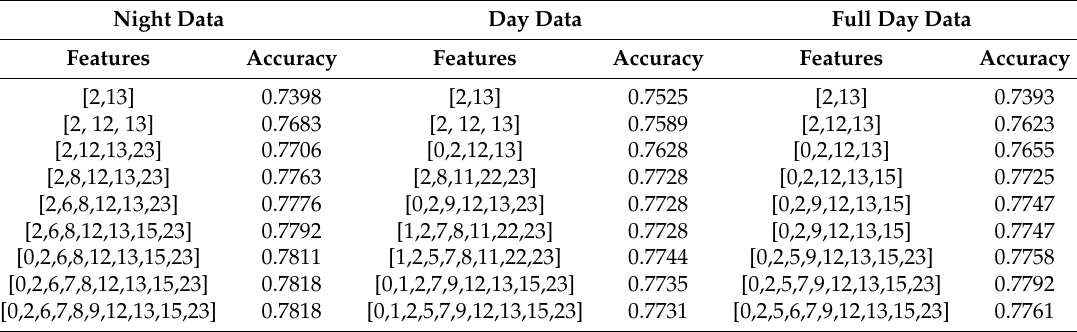
Table 4. Forward Selection results for the night, day and full day data.